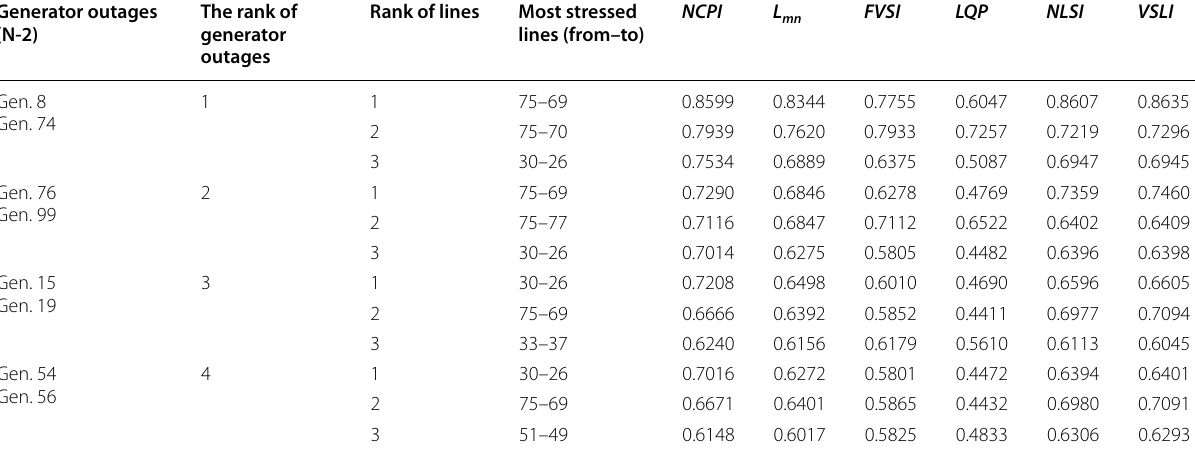
Table 13 Contingency ranking and analysis of the IEEE 118-bus system with two generator outages and pre-specified reactive power load at nodes 11, 20, 30, 33, 51, 75 and